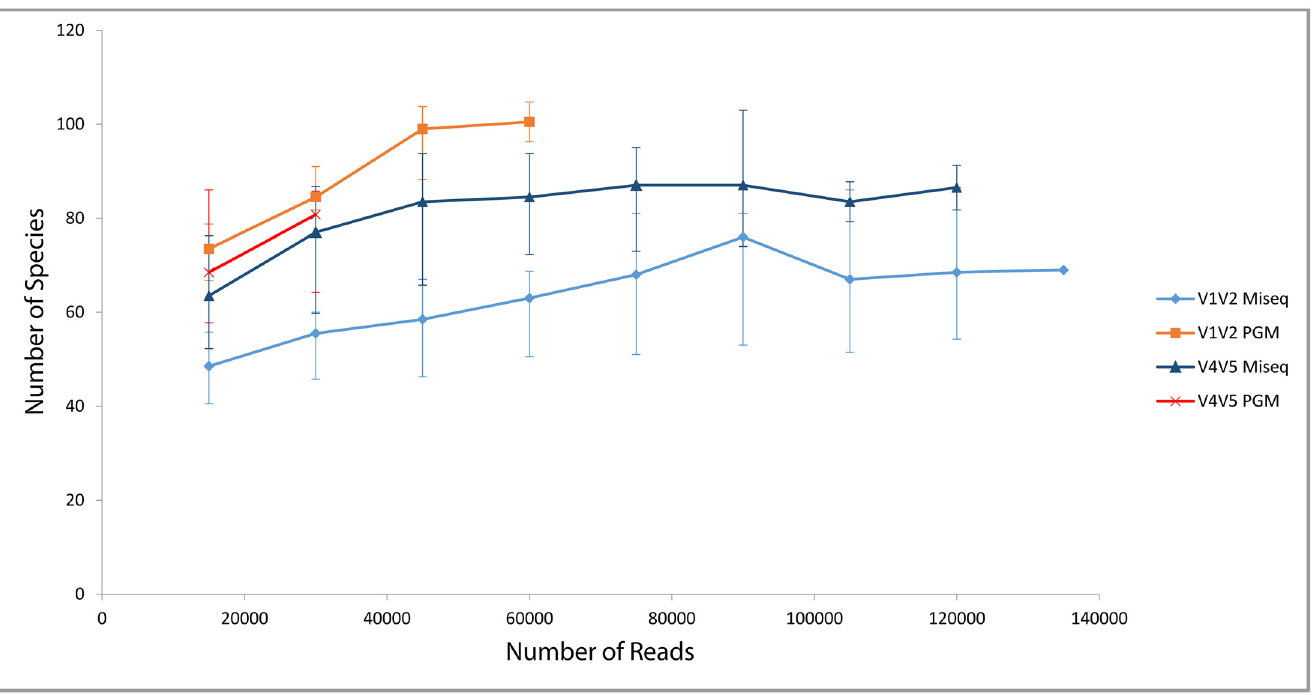
Fig 3. Observed Species at various sequencing depths for the amplicon data using SPINGO. The data points represent the median values across the 6 samples and the error bars are the 25% and 75% quartile ranges.